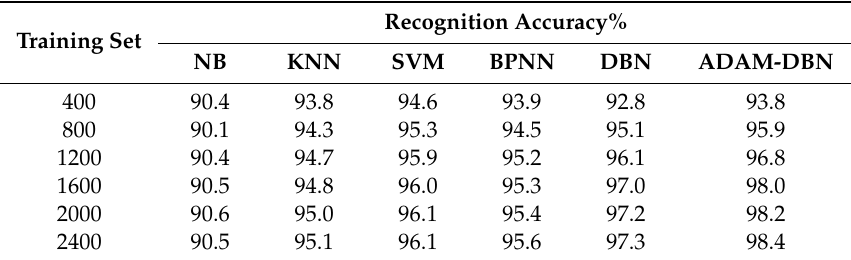
Table 1. Recognition accuracy on di ff erent scales of training sample